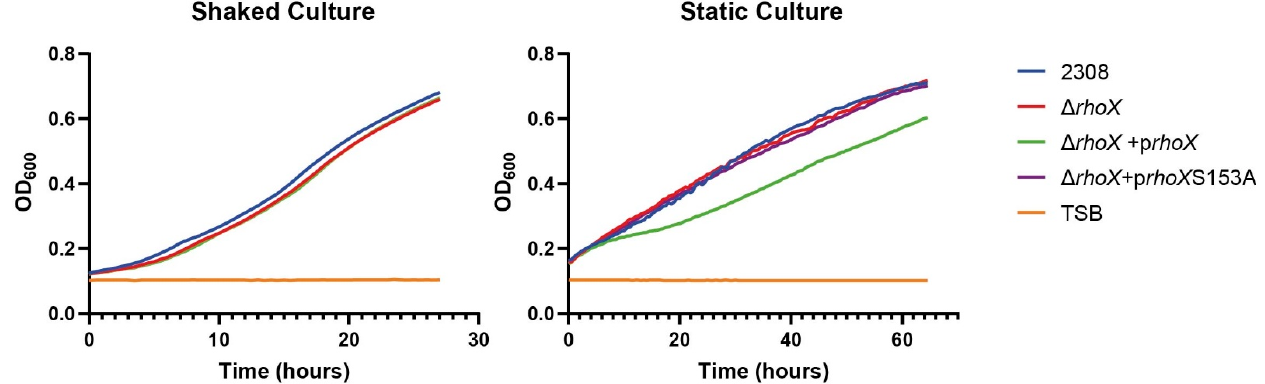
Figure 7. Growth curves under shake or static conditions. Overnight TSB cultures of the indicated strains were diluted in TSB to the same initial OD 600 . For shake conditions, 100 μ L of diluted cultures were plated in p96 microplates while 250 μ L of diluted cultures were plated for the static condition. Automated growth curves were performed in a multiwell plate reader, following the OD 600nm every 30 min at 37 °C on maximum agitation or without agitation. Non-inoculated medium (TSB) was included as a control. Figure shows a representative of 2 experiments with 3 to 5 biological repli- cates.